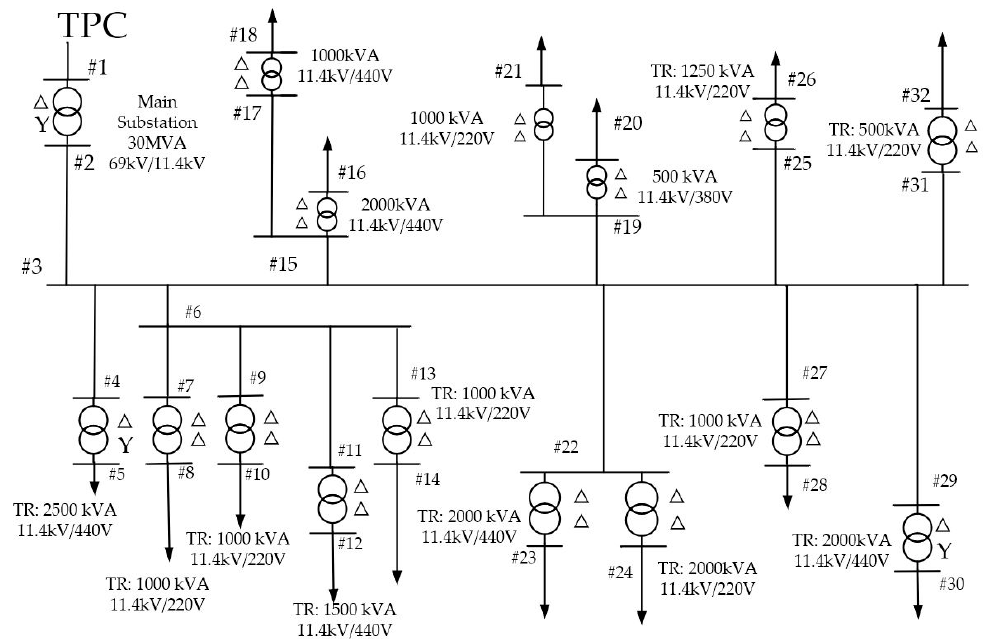
Figure 9. The 32-bus system of a chemical factory.